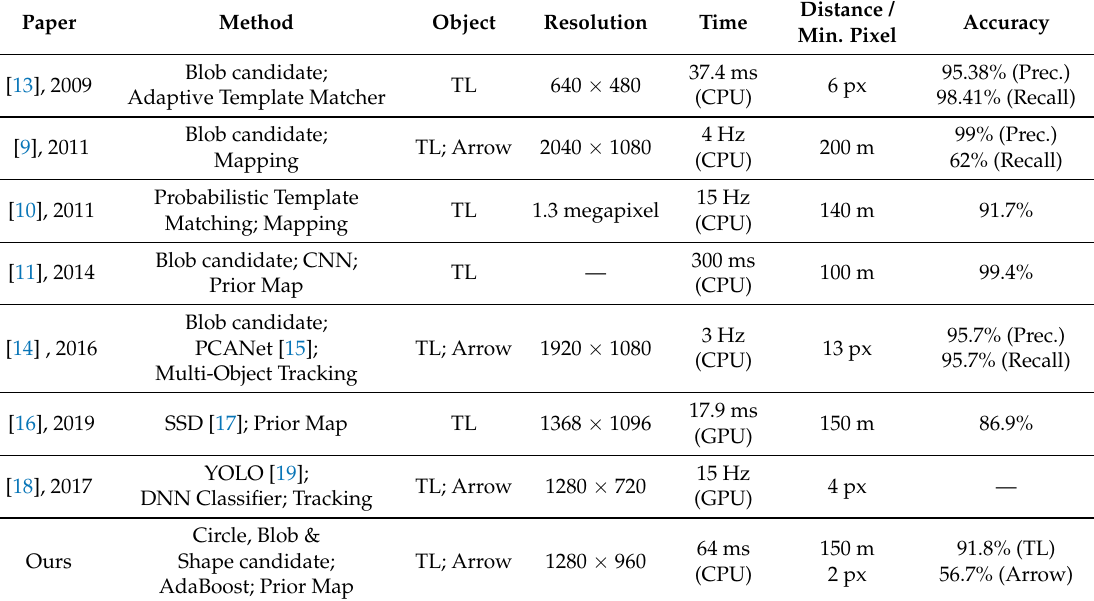
Table 1. Summary of relative studies for traffic light